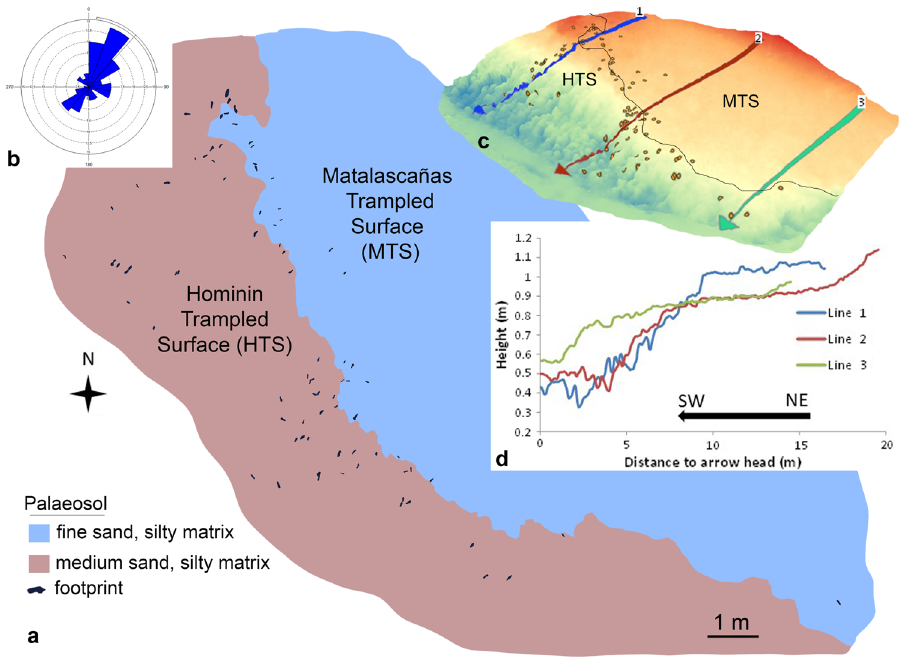
Figure 3. Mapping of the hominin footprints (HTS) and animal tracks (MTS). ( a ) Plan view. ( b ) Wind rose, showing the preferential direction SW-NE of the footprints. ( c ) 3D model of the palaeosol surface with the footprints’ location and its relationship with the MTS. ( d ) Elevation profiles according to sections 1 to